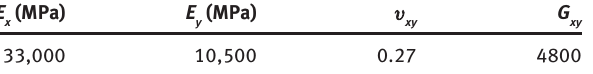
Table 1 Mechanical properties of composite adherends. Table 2 Mechanical properties of adhesive.